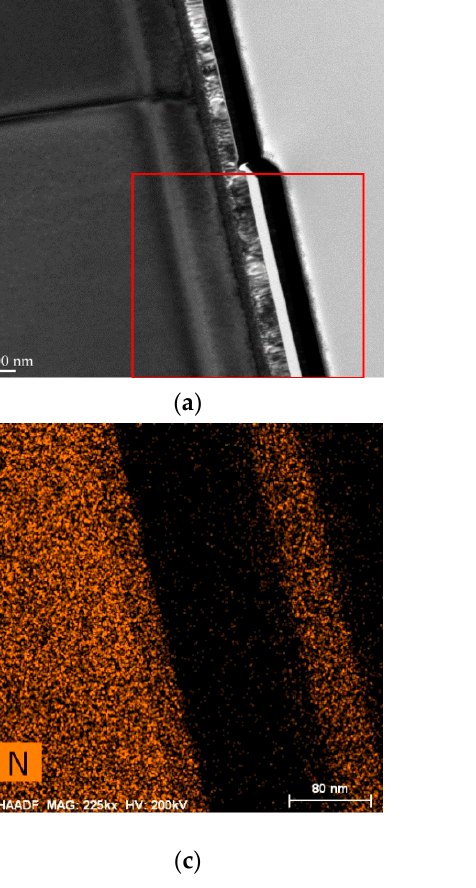
Figure 7. ( a ) TEM and ( b – d ) HAADF STEM images of weakly annealed area 1 in the MSM AlGaN UV